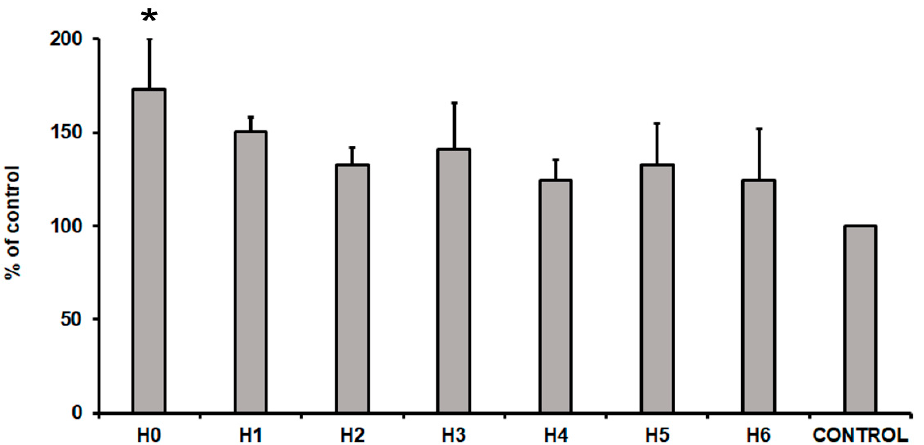
Figure 14. The cytotoxicity of liquid extracts of chitosan-based samples (H0: chitosan (CS); H1: CS / graphene oxide (GO); H2: CS / poly(ethylene glycol) grafted graphene oxide (GO-PEG); H3: CS / reduced graphene oxide (rGO); H4: CS / GO / hydroxyapatite (HAp); H5: CS / GO-PEG / HAp; H6: CS / rGO / HAp) towards hUC-MSCs (human umbilical cord Wharton’s jelly mesenchymal stem cells) after 24 h of the cell culture. Data are expressed as mean ± SD. P value less than 0.05 ( p < 0.05) was considered as statistically significant and labeled by an asterisk ( * ).